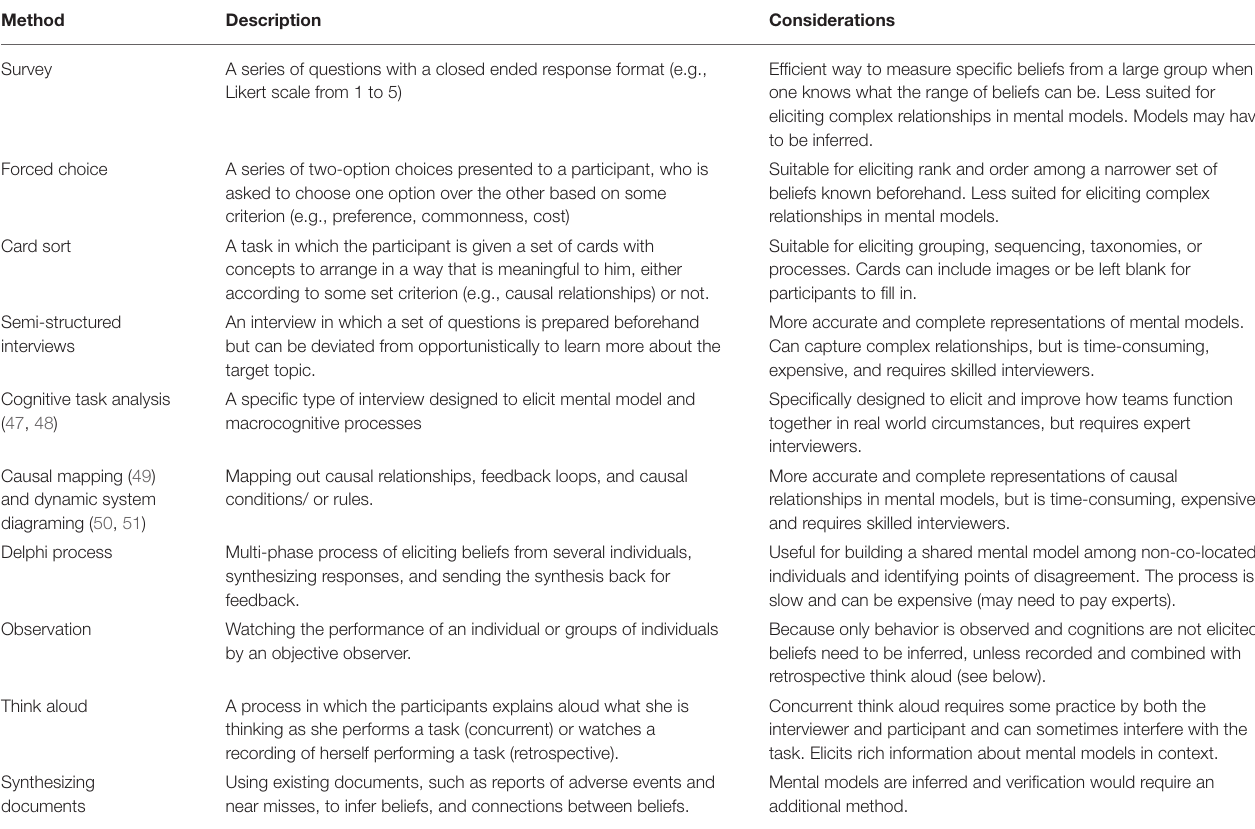
TABLE 1 | Overview of common mental model elicitation